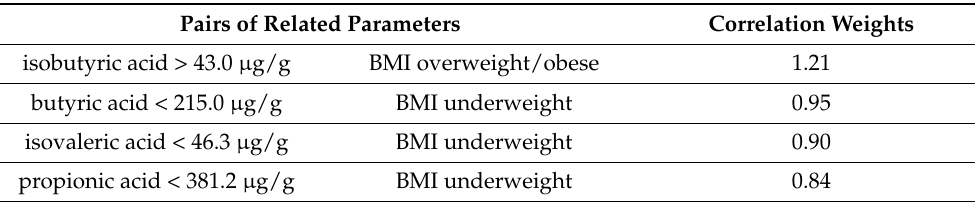
Table 2. Association weights for FA levels and BMI categories, based on the correspondence analysis model (body mass index (BMI) overweight/obese—BMI > 25 kg/m 2 ; BMI underweight—BMI < 18.5 kg/m 2 ).